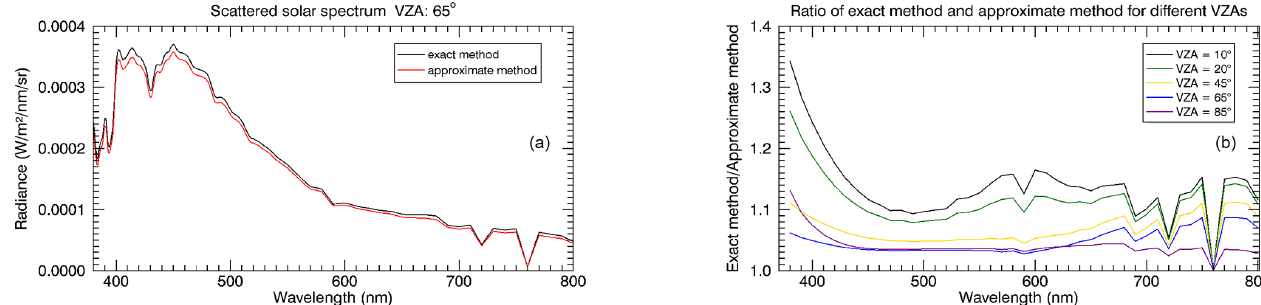
Figure 12. (a) Solar scattering spectra for VZA = 65 ◦ calculated with the exact method (black line) and the approximate method (red line). (b) Ratio of the exact method and the approximate method for different VZAs. For all simulations, SZA = 98 ◦ and SAA = 0 ◦ . The NLC parameters are the following: r m = 50nm, S = 1 . 4, τ NLC = 10 − 4 and z NLC = 82km.